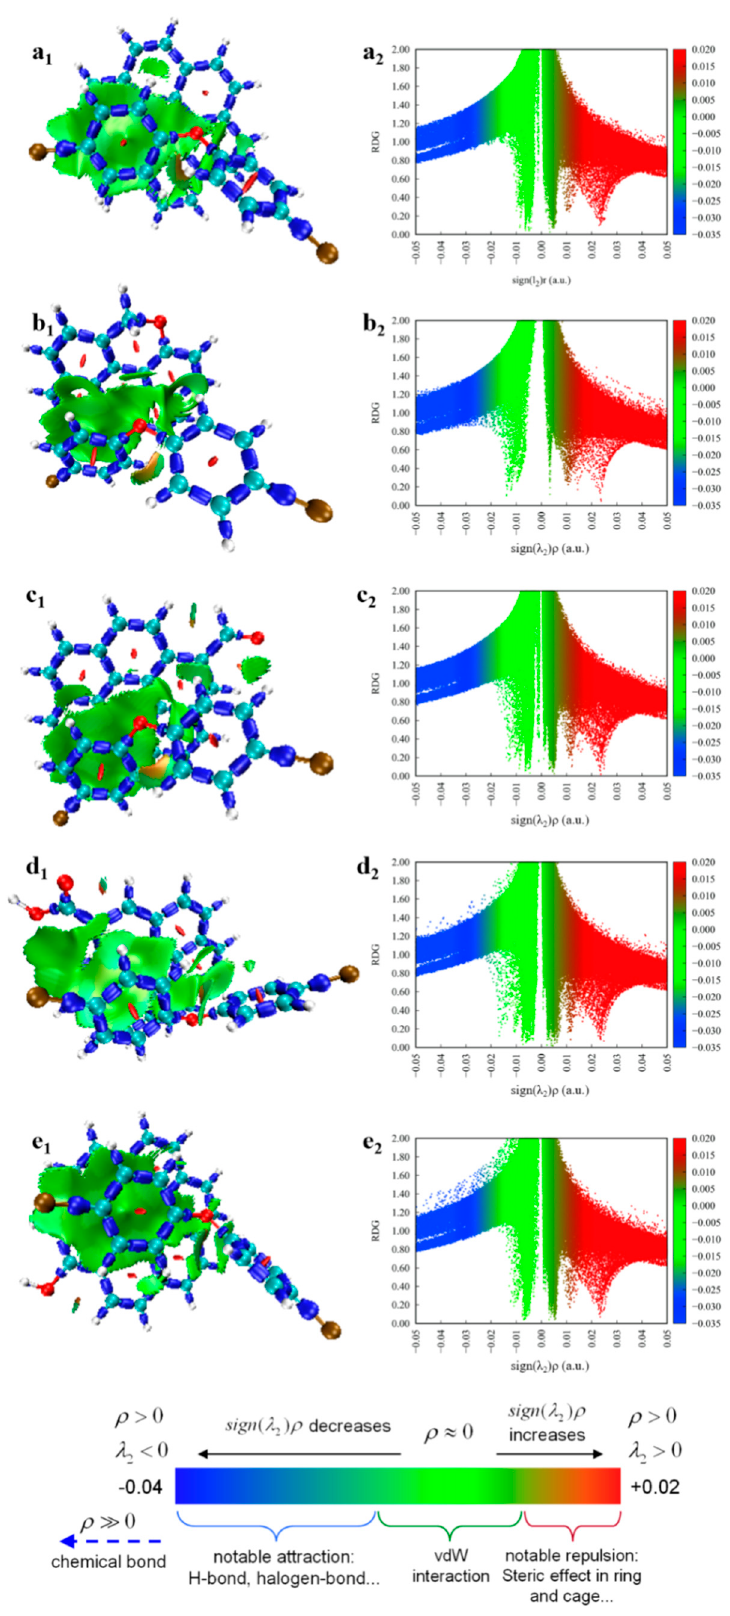
Figure 10. IRI isosurface plots of BDE-15 with ( a 1 ) Coronene, ( b 1 ) Coronene − C − O − C, ( c 1 ) Coronene − CHO, ( d 1 ) Coronene − COOH, ( e 1 ) Coronene − OH complexes and corresponding RDG scatter ( a 2 , b 2 , c 2 , d 2 , e 2 ).